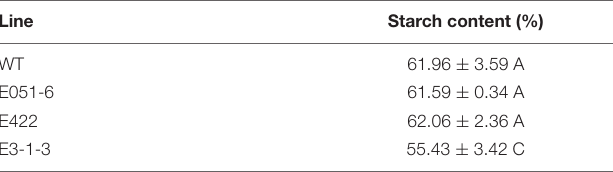
TABLE 2 | Differences in starch content of mature